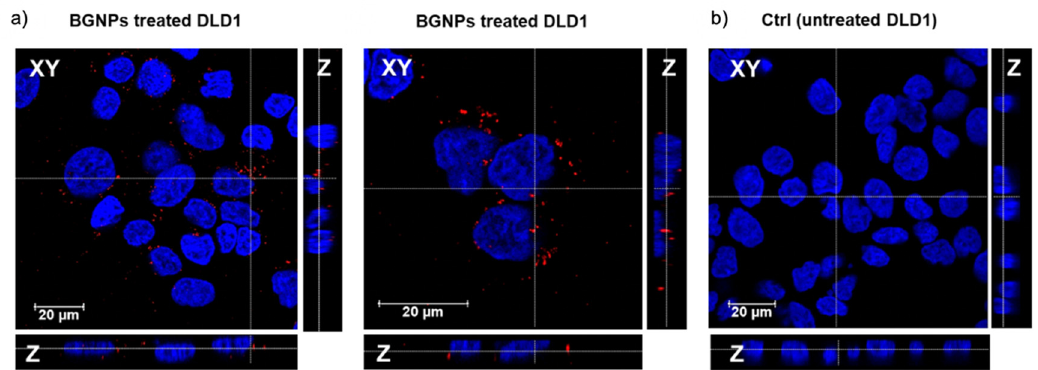
Figure 4. Confocal microscopy analysis. Representative images showing the XY planes and Z projections for ( a , b ) DLD1 cells after 24 h of BGNP exposure and ( b ) untreated DLD1 cell control. Nuclei are visualized by Hoechst staining (blue); BGNPs are visualized by reflected light (red). Bright filed XY transmission images are reported in Figure S3.